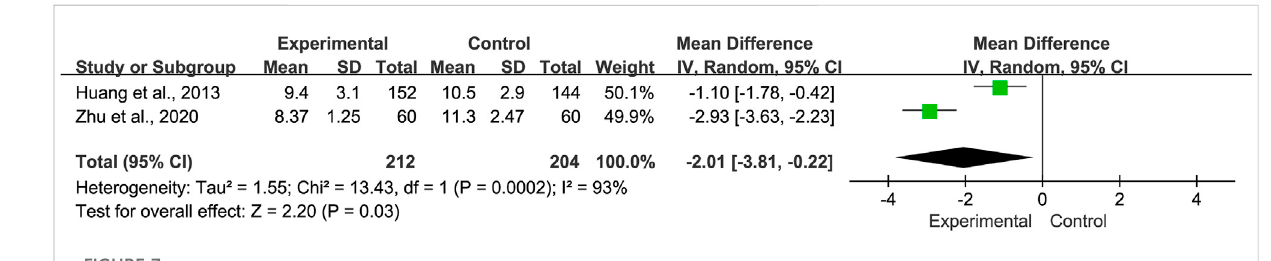
FIGURE 7 Forest plot for hospital stay